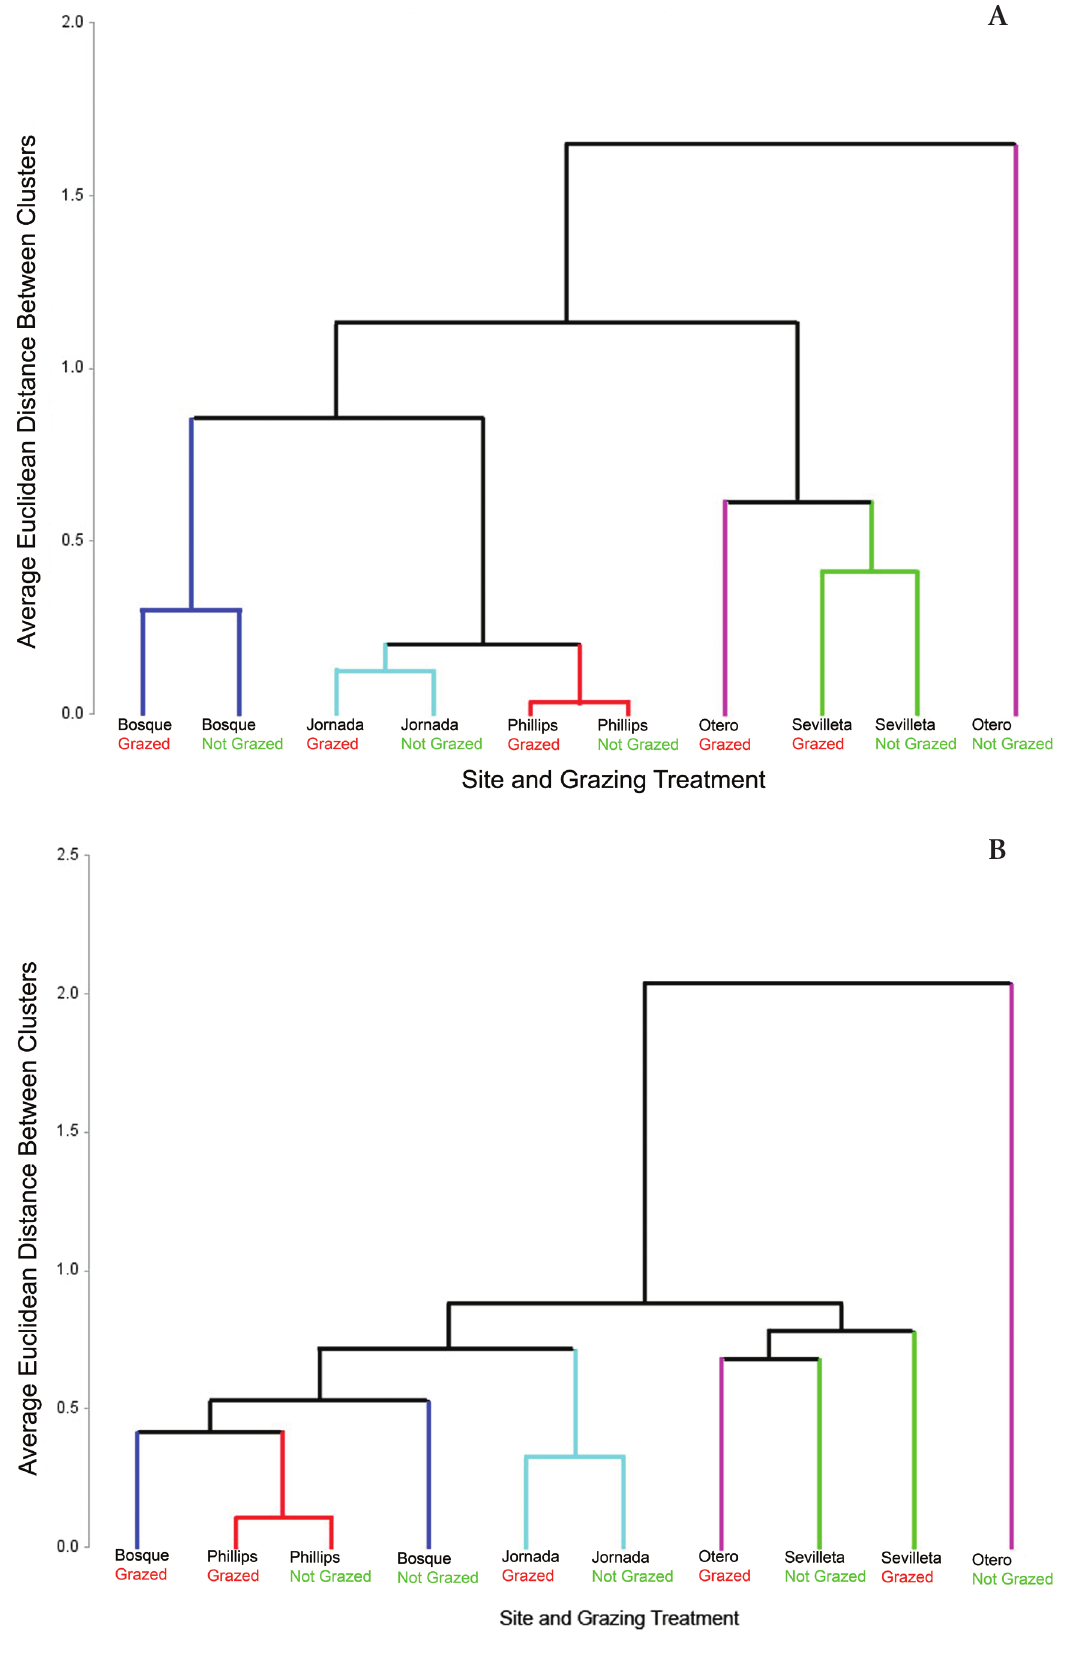
Fig. 6. Cluster analysis dendrograms showing site and grazing treatment similarities of grasshopper species compositions; A. Spring; B.